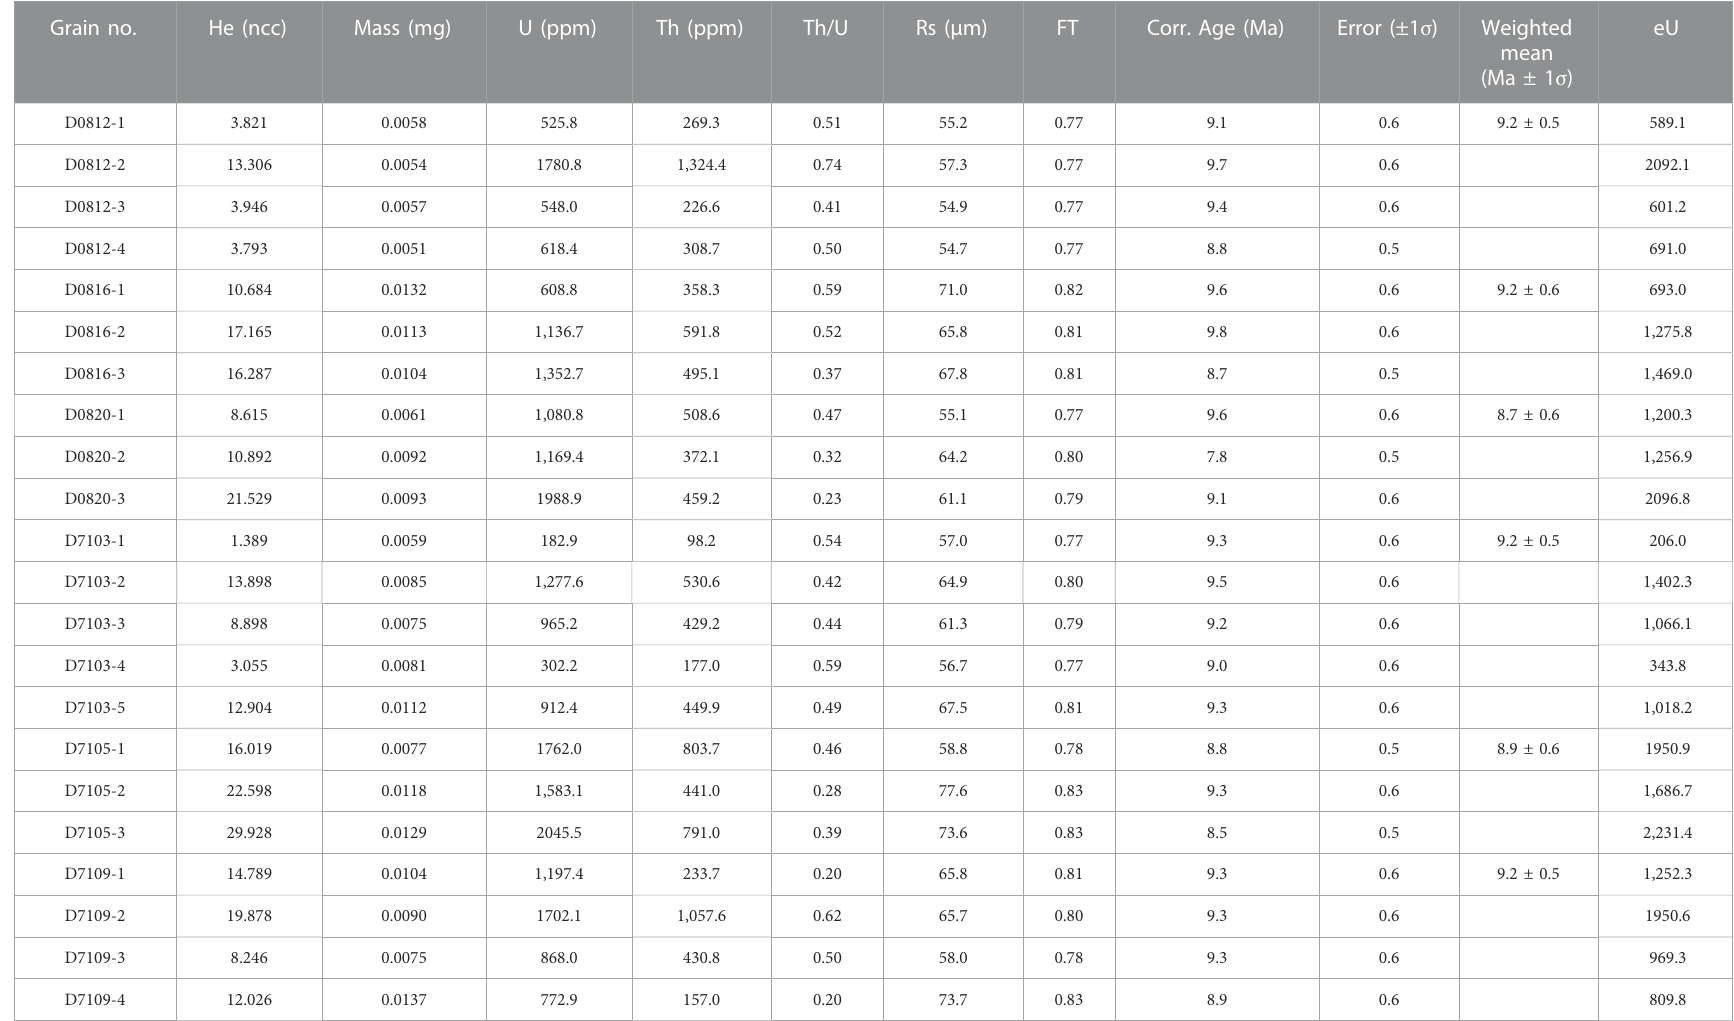
TABLE 3 Single-grain zircon (U-Th)/He results from the Kangmar dome. Grain